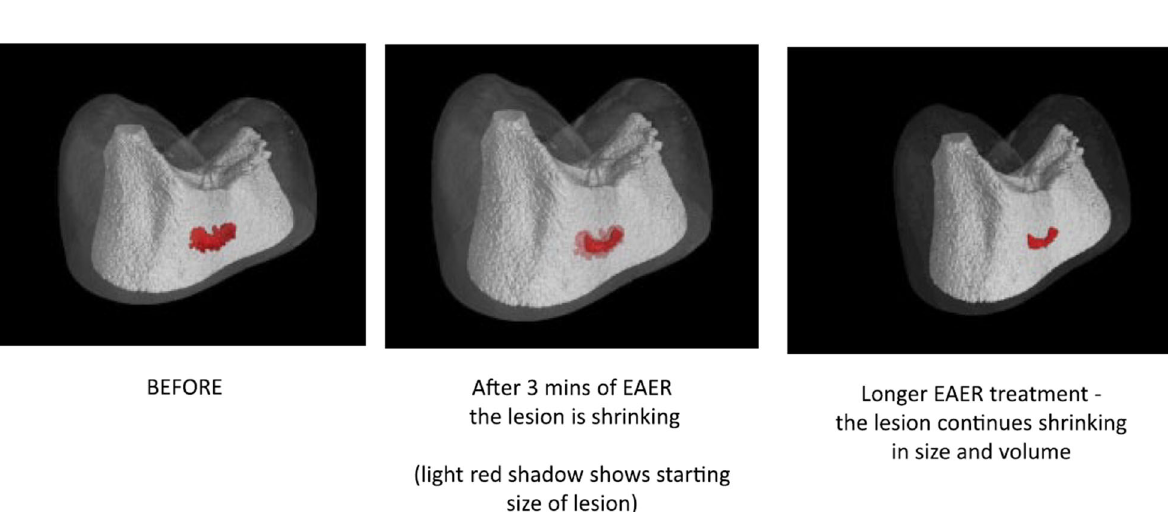
Fig. 8 Schematic of the ADGS. The PDA-modi fi ed substrates were coated by AAO membrane, a calcium-containing gelatin hydrogel and an ion-free gelatin hydrogel, from bottom to top. Phosphate solution was added to the top for mineralisation through ion diffusion. Reproduced with permission from ref. [73]